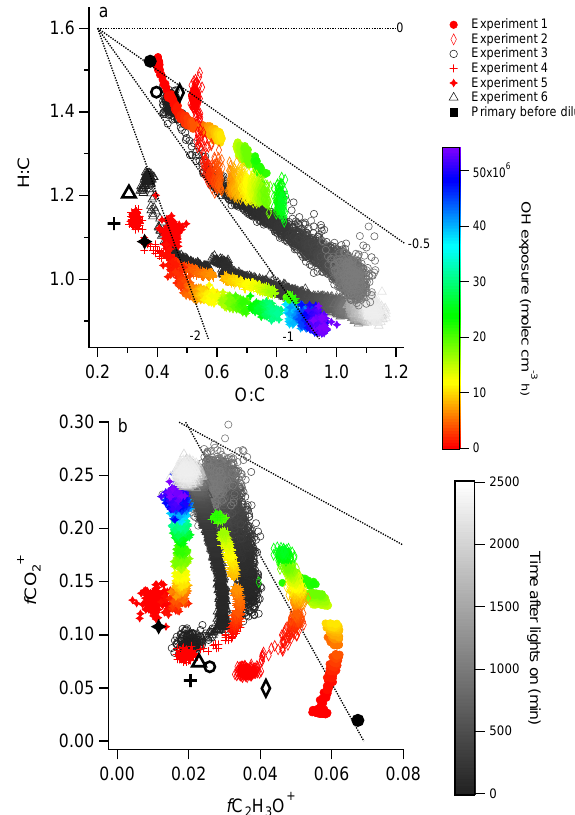
Figure 5. (a) Van Krevelen diagram and (b) f CO + of f C 2 H 3 O + determined from HR-AMS analysis. Experiments 1, 2, 4 and 5 are colored by OH exposure. Experiments 3 and 6 are colored in greyscale by minutes after lights-on. Thick black markers indicate the primary point for each experiment, immediately after injection and prior to dilution. For comparison, the region in which OA measurements are typically located (Ng et al., 2011) is drawn on (b)